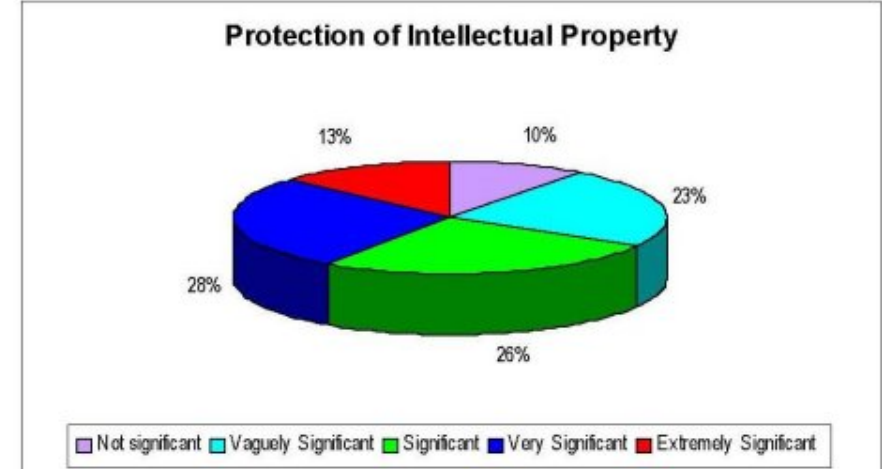
Figure 8 Respondent votes on the protection of intellectual